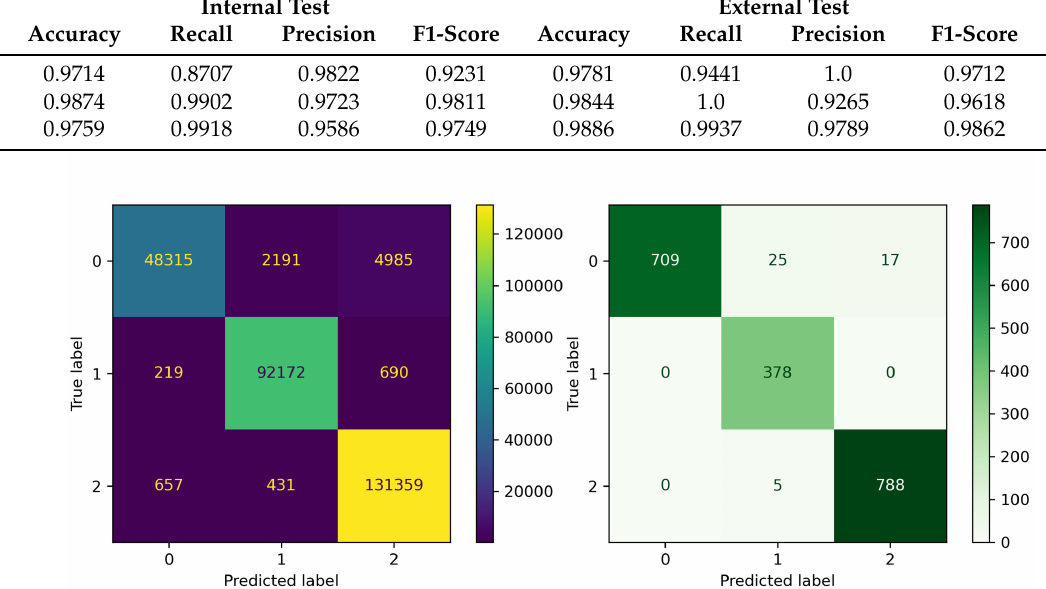
Table 4. The performance (recall, precision, and F1-score) of our optimal XGBoost model on the internal and external test sets.